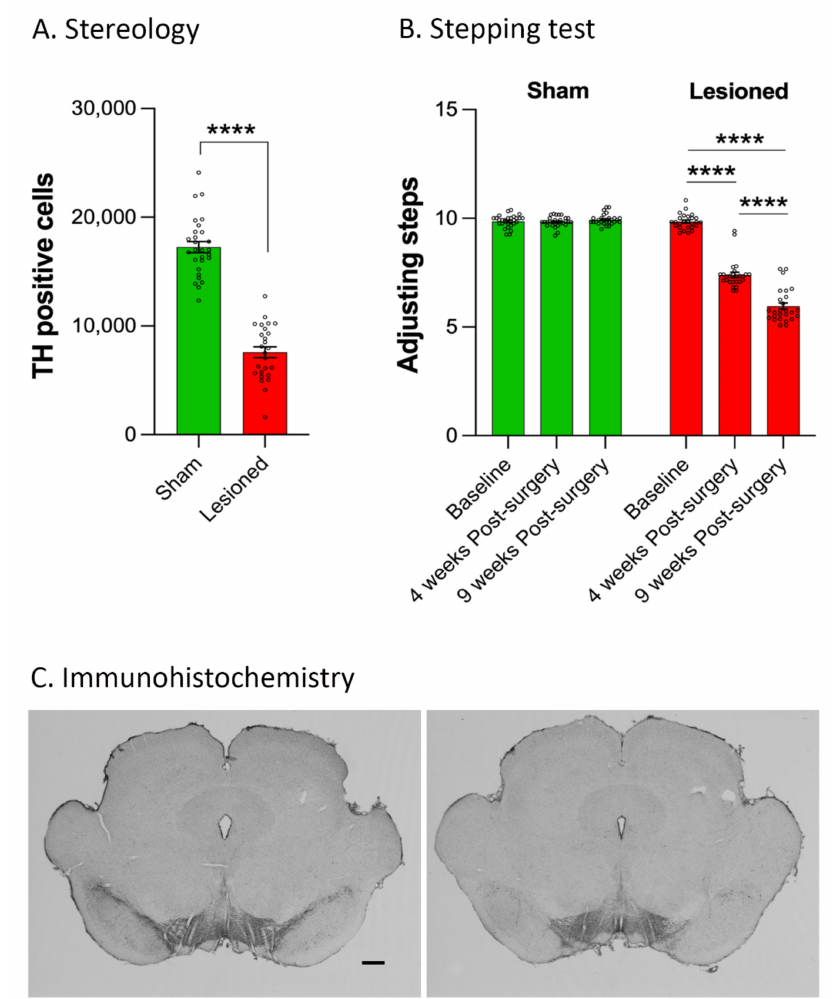
Figure 2. Alpha-synuclein-induced neurodegeneration and motor deficits. ( A ). Stereological counts of the numbers of tyrosine hydroxylase (TH) positive neurons in the substantia nigra pars compacta in animals injected with an AAV expressing the green fluorescent protein (GFP, Sham) or human A53T α -synuclein (Lesioned). ****, p < 0.0001. ( B ). Motor performances as assessed with the stepping test at baseline, 4 and 9 weeks after surgery. ( C ). Representative images of TH immunohistochemistry in Sham (left panel) and lesioned animals (right panel). Scale bar = 500 µ